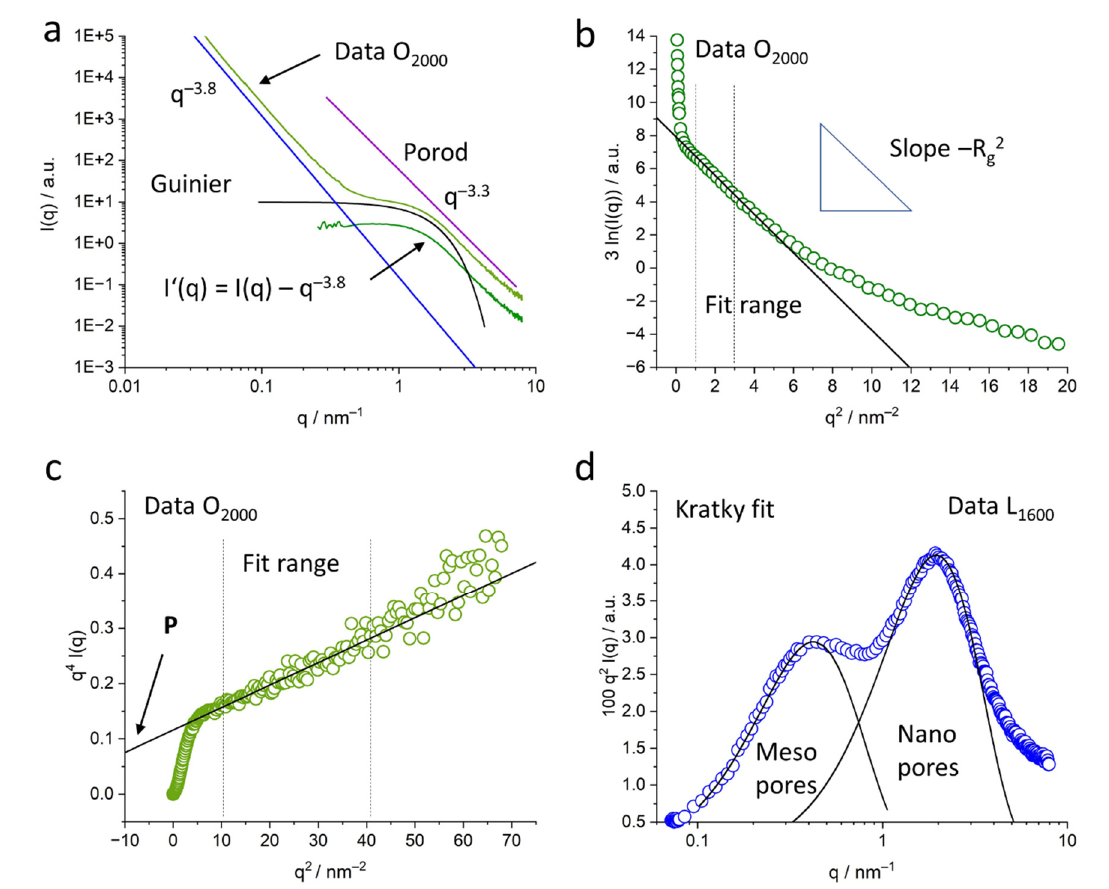
Figure 6. Display of the evaluation procedures applied to the data. ( a ) Original data I ( q ) of O 2000 with the mid-q power law, Porod’s power law, modified scattering curve I’ ( q ) and Guinier approximation of the pores; ( b ) Guinier fit to O 2000 data to determine R g by a linear fit; ( c ) Porod fit to O 2000 data in order to determine the Porod constant P from the intercept of the fit function with the q 4 ∙ I ( q ) axis; ( d ) Kratky plot for L 1600 data with the Gaussian fit functions related to the meso- and nanopores.